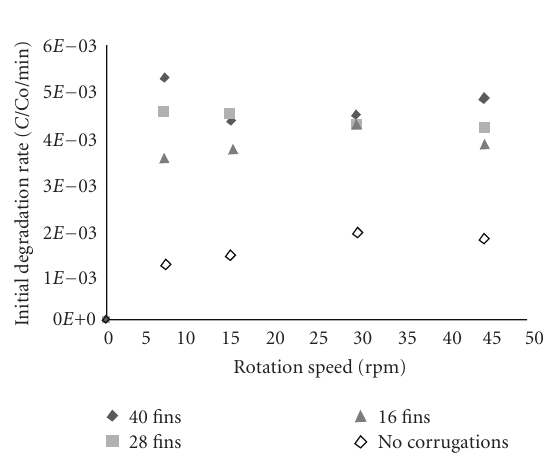
Figure 6: E ff ect of varying rotational speed on initial degradation rate for corrugated drums.